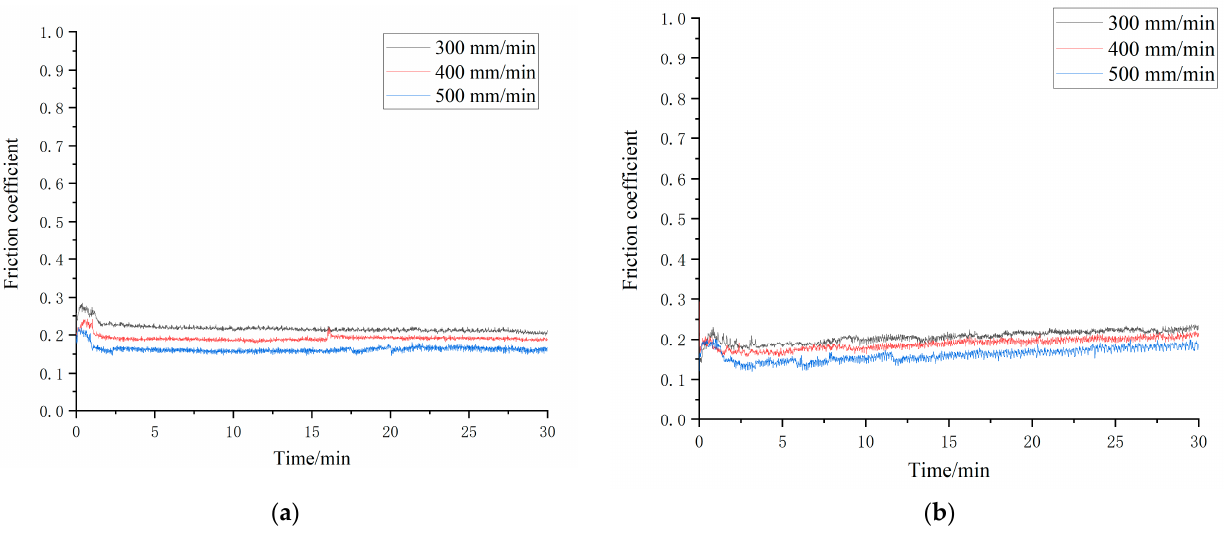
Figure 4. Friction coefficient; ( a ) Friction coefficient of the hardened layer after laser hardening with a scanning speed of 700 mm/min. ( b ) Friction coefficient of the hardened layer after laser hardening with a scanning speed of 800 mm/min.